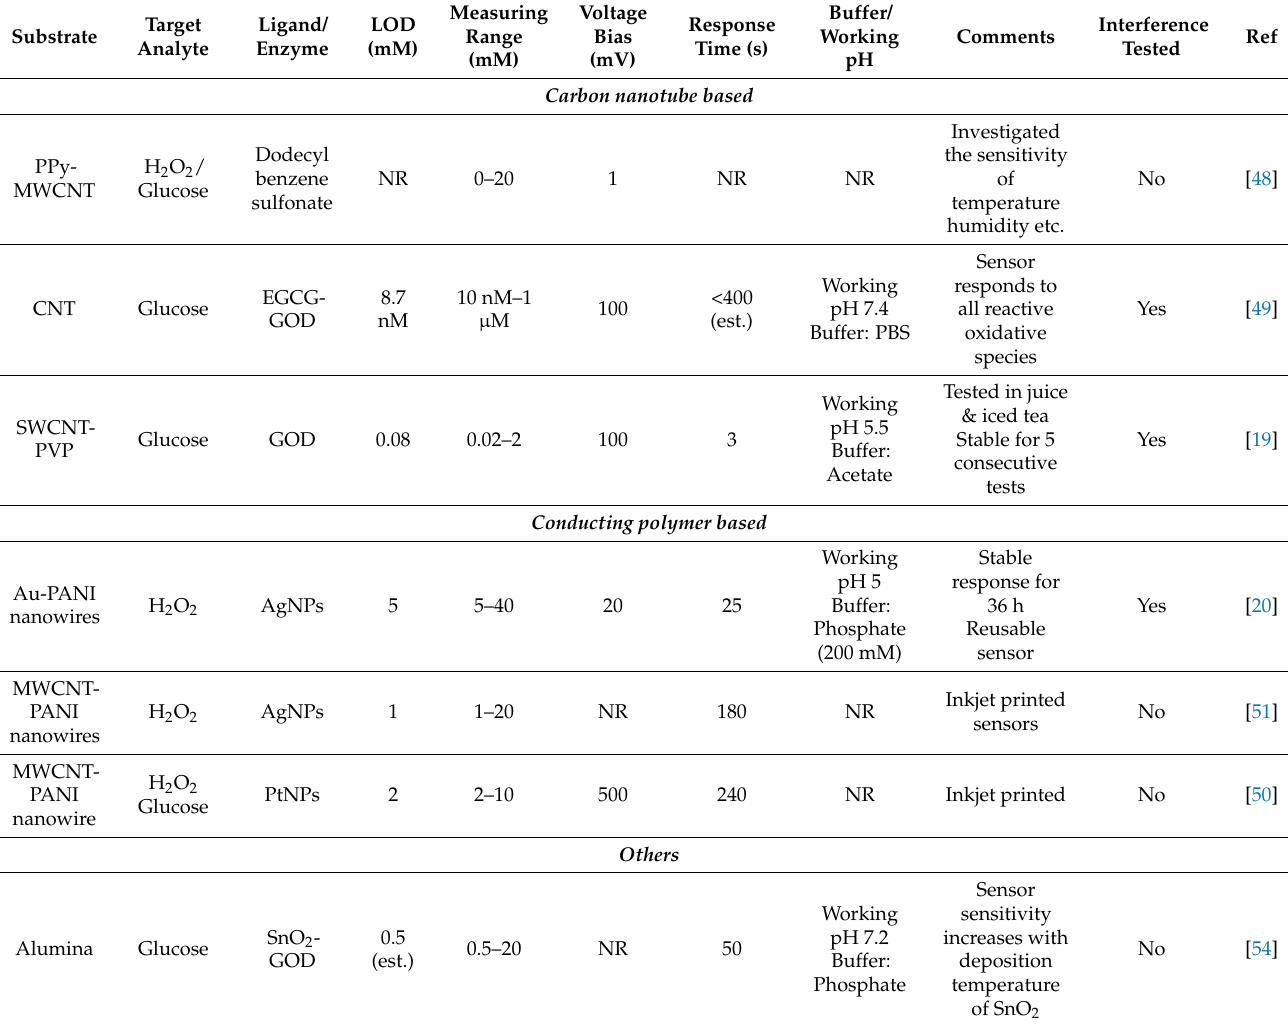
Table 1. A list of H 2 O 2 chemiresistive sensors with the crucial sensor properties including LOD, measuring range, voltage bias, response time, buffer and working pH. All units are as mentioned in the top row unless specified. Where NR: Not reported, PPy: Polypyrrole, PANI: Polyaniline, Pt NPs: Platinum nanoparticles, SnO 2 : Tin oxide, Au: